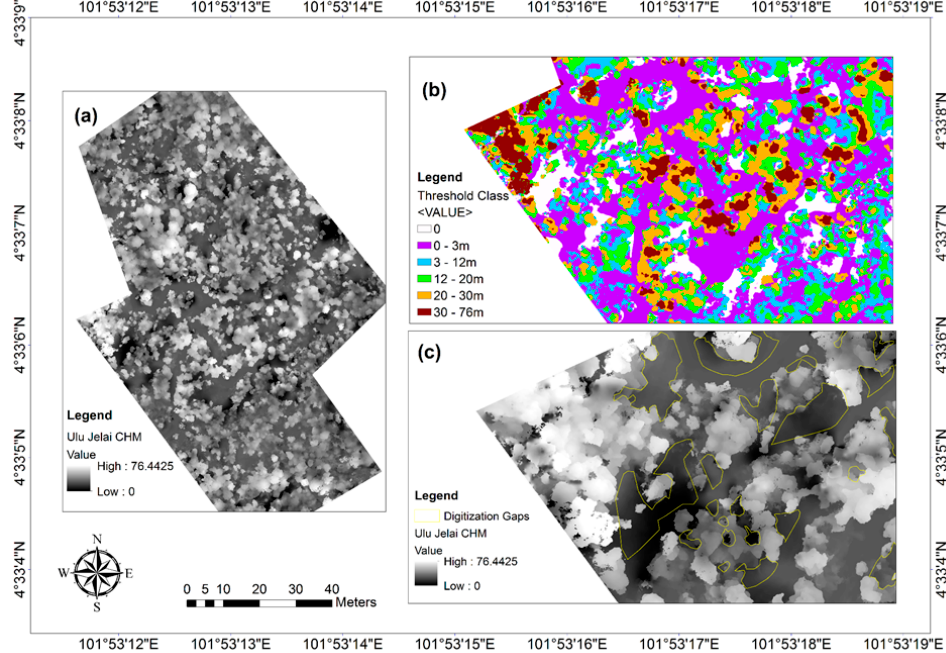
Figure 8. Sampling design of canopy gap datasets: ( a ) CHM; ( b ) CHM height classes; and ( c ) forest gap digitization.